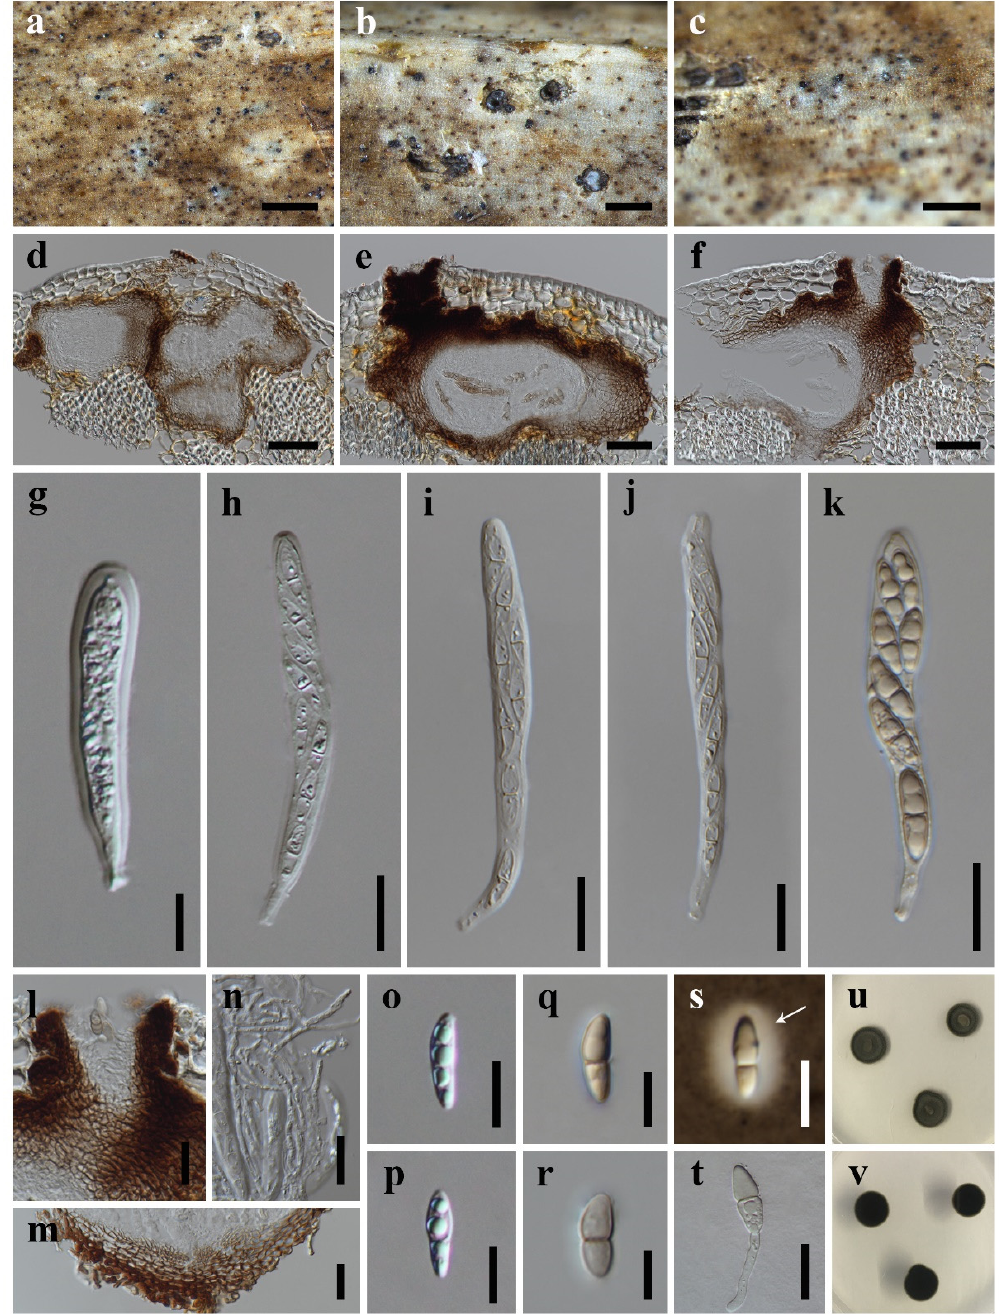
Figure 2. Brunneofusispora inclinatiostiola (HKAS 113022, holotype ) ( a – c ) Ascomata on host substrate. ( d – f ) Vertical section of ascoma. ( g – k ) Asci. ( l ) Ostiole, showing periphyses. ( m ) Structure of peridium. ( n ) Pseudoparaphyses. ( o – s ) Ascospores ( s ) Arrow indicated mucilaginous sheath). ( t ) Germinated ascospore. ( u , v ) Colonies on PDA, above ( u ) and reverse ( v ). Scale bars: ( a ) = 1000 μ m, ( b , c ,) = 500 μ m, ( d – f ) = 50 μ m, ( g , o – s ) = 10 μ m, ( h – n , t ) = 20 μ m.